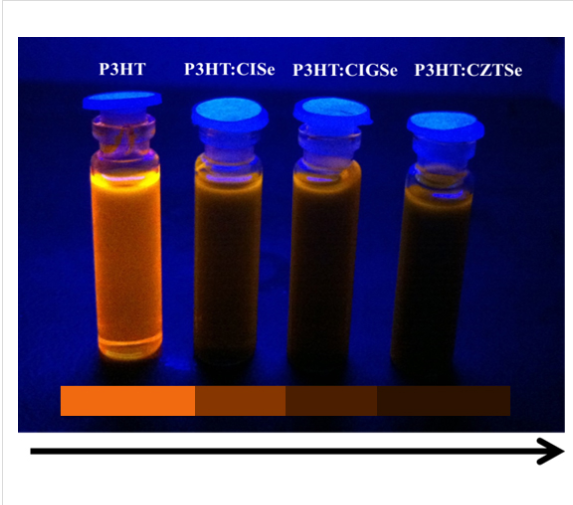
Figure 4: UV-lamp exposed photographs of polymer P3HT, P3HT:CISe, P3HT:CIGSe and P3HT:CZTSe nanocomposites.